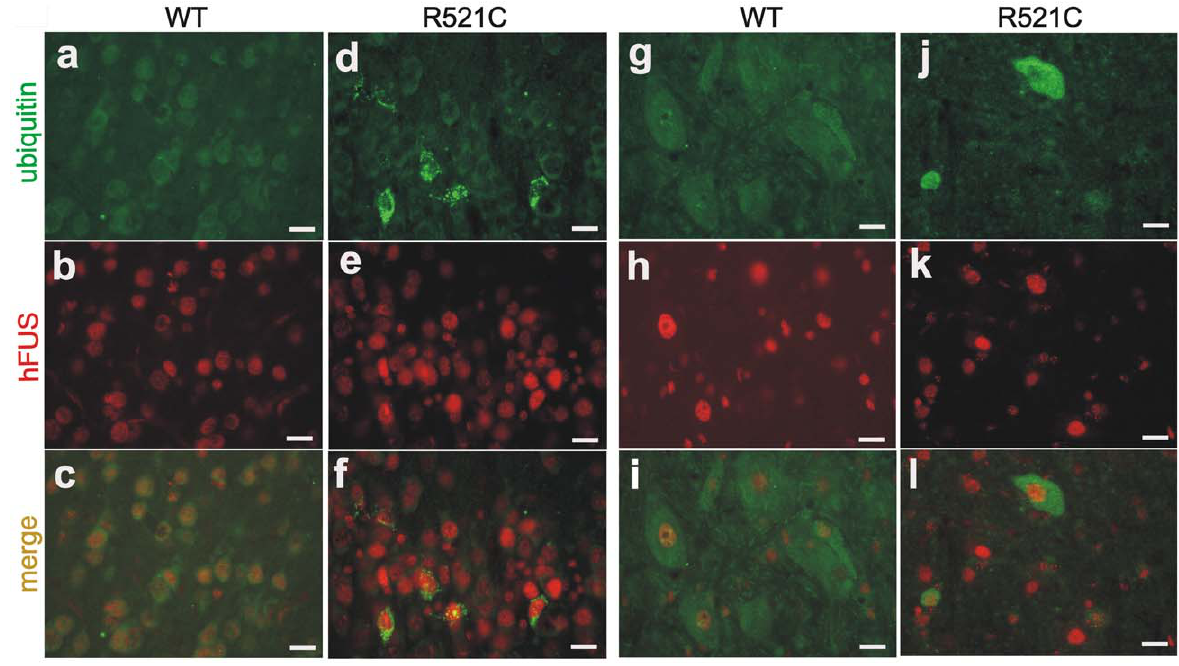
Figure 5. Accumulation of ubiquitin in mutant FUS transgenic rats. (A–L) Double-fluorescence staining revealed accumulation of ubiquitin in the cortex (D–F) and spinal cord (J–L) of the mutant FUS transgenic rats (line 16) at paralysis stages, but not in tissues of the age-matched normal FUS transgenic rats (line 20) (A–C: cortex; G–I: spinal cord). Coronal sections of the frontal cortex and traverse sections of the lumbar cord were immunostained with antibodies to ubiquitin (green) and human FUS (red). Scale bars: A–F, 20 m m.